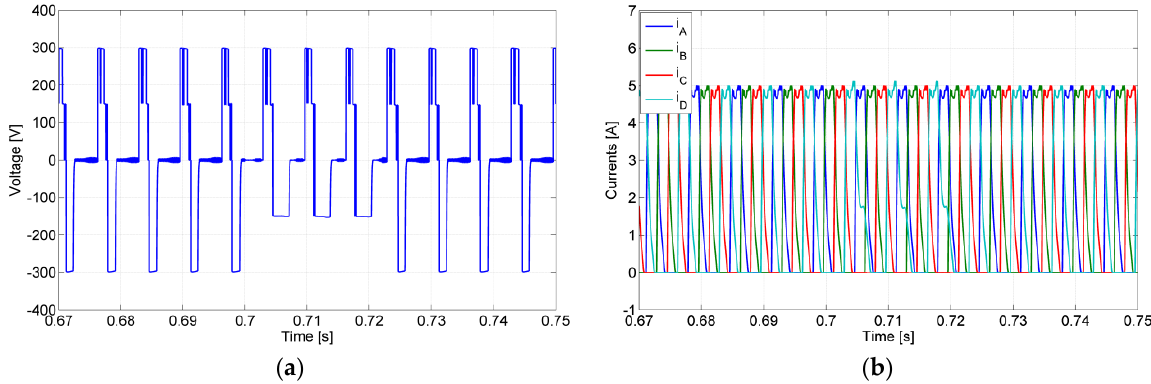
Figure 14. Simulation test with the converter operating in normal mode until t = 0.7 s and after that with a short-circuit fault in the semiconductor S 24 ( a ) winding voltage of phase D ; ( b ) winding currents. Fault-tolerant mode after t = 0.73 s.